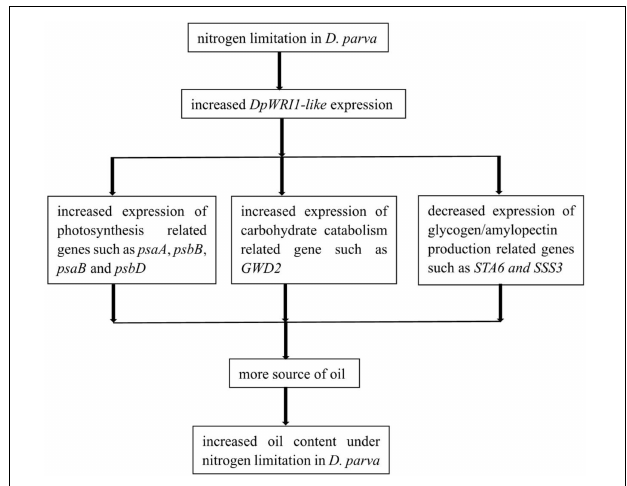
FIGURE 10 | A hypothetical diagram about the mechanism of oil accumulation induced by DpWRI1-like under nitrogen limitation condition.